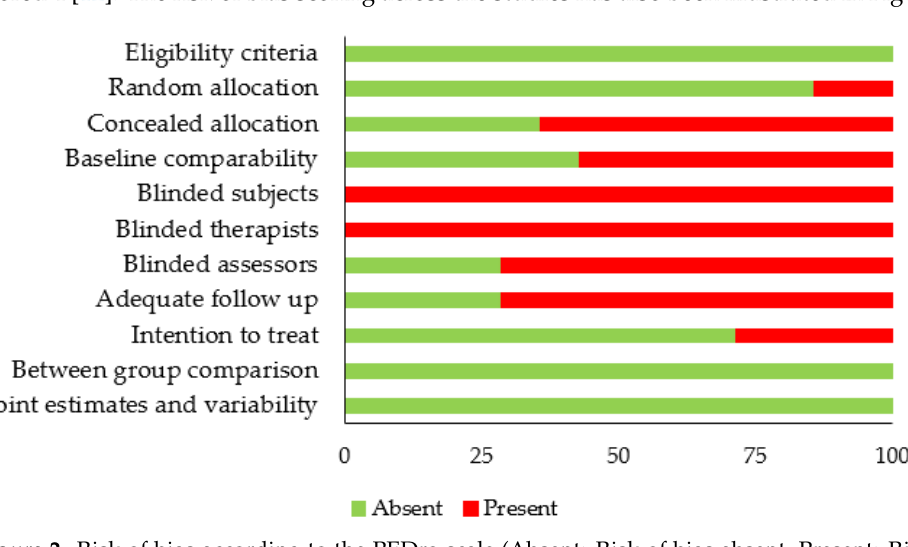
Figure 1. PRISMA flowchart.